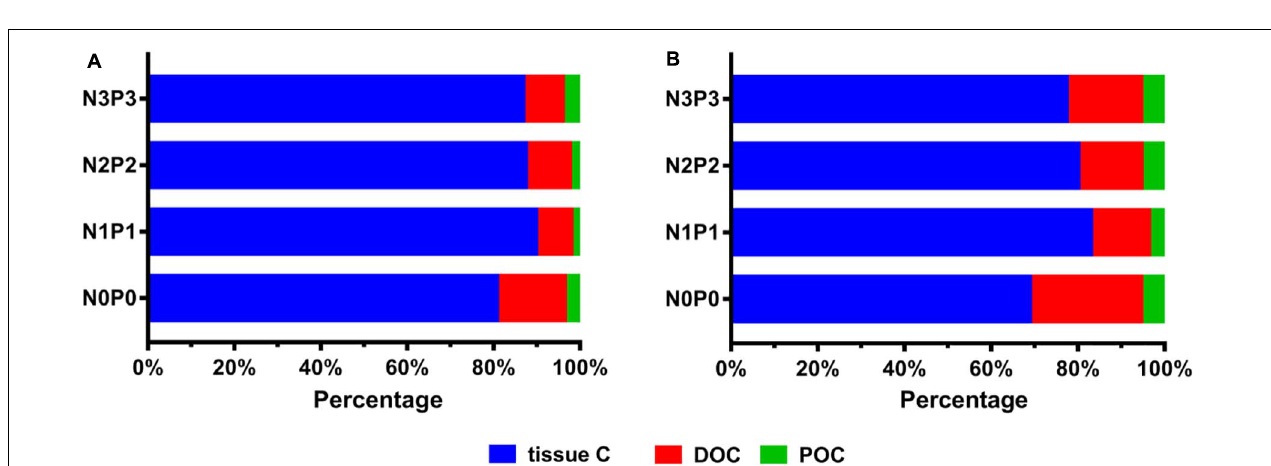
FIGURE 7 | The percentage of organic carbons of Z-61 (A) and Z-26 (B) . Bars in blue, red, and green color represent tissue carbon, dissolved organic carbon (DOC), and particulate organic carbon (POC), respectively.